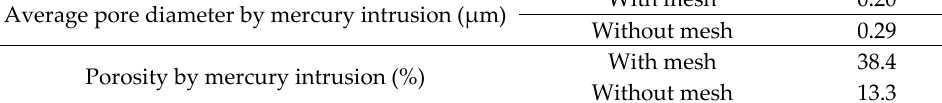
Figure 6. Porosimetry properties obtained by mercury intrusion of cement mortar applied to concrete slab substrate, with and without mesh.